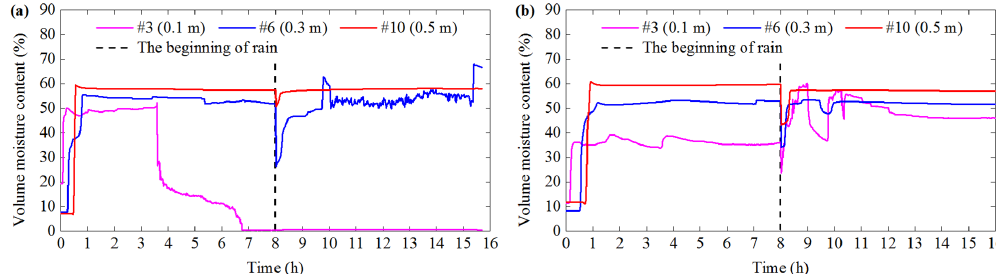
Figure 8. Volume moisture content at position C of (a) test 3 and (b) test4.